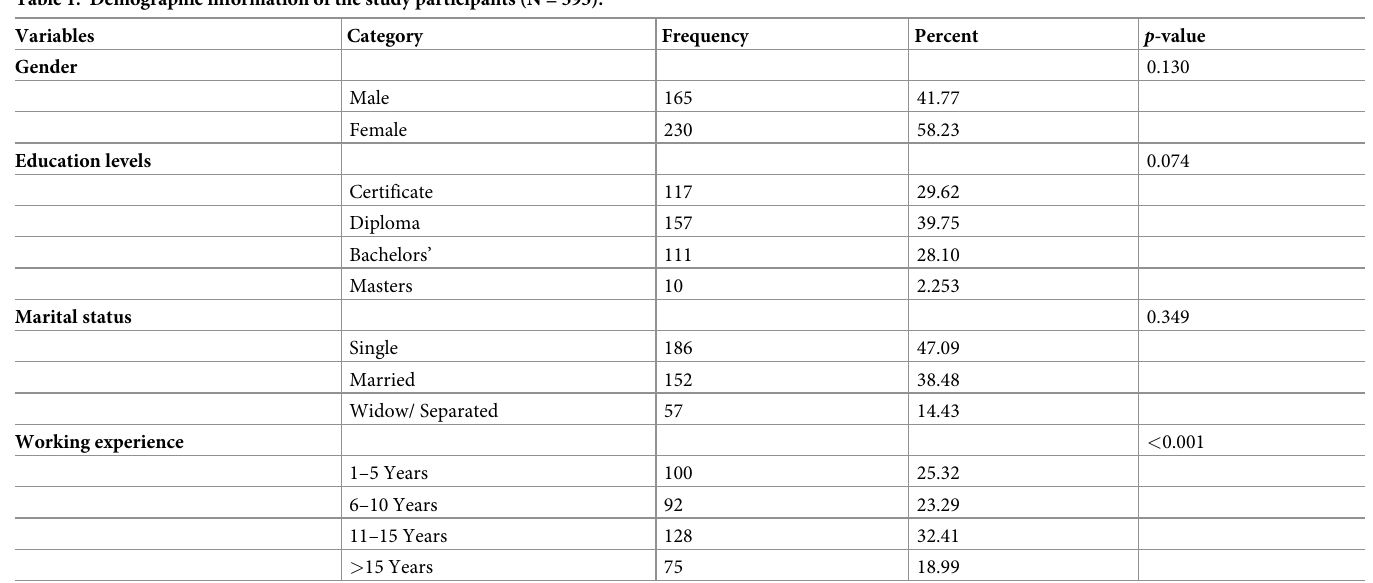
Table 1. Demographic information of the study participants (N = 395).